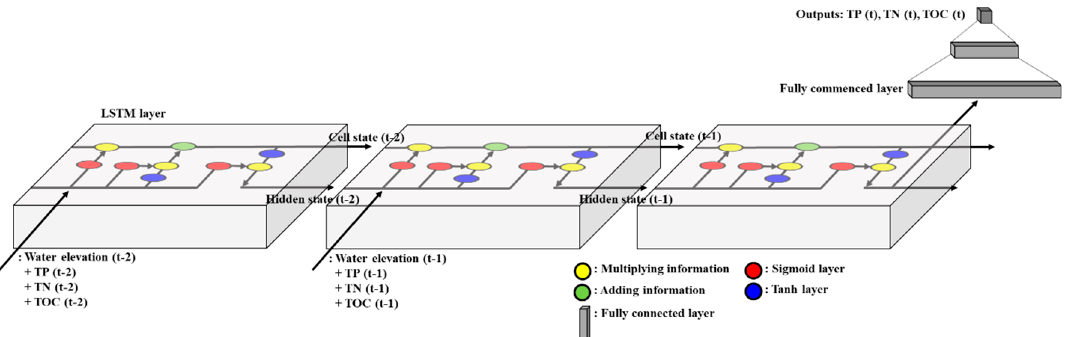
Figure 3. Architecture of the proposed Long Short-Term Memory (LSTM) model in this study, consisting of an LSTM and a fully connected layer to simulate the water quality concentrations.